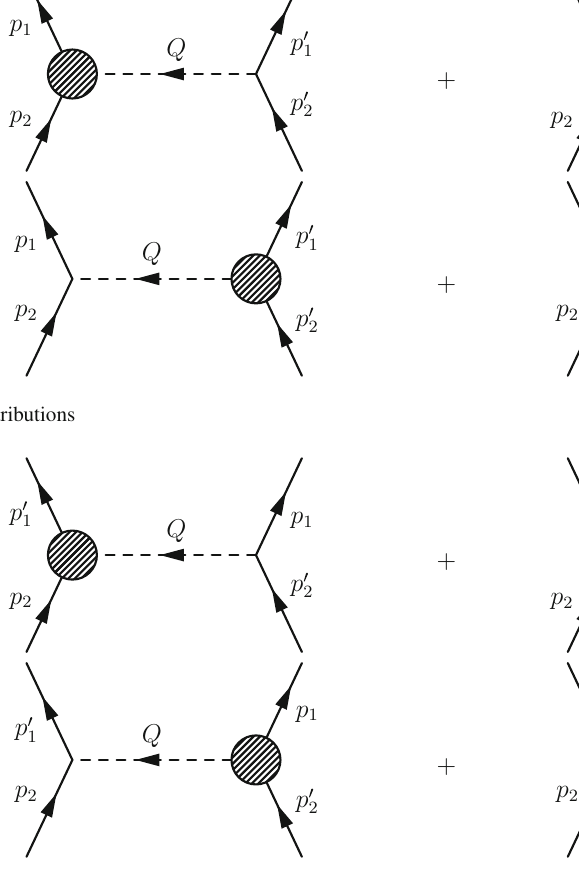
Fig. 6 S matrix contributions